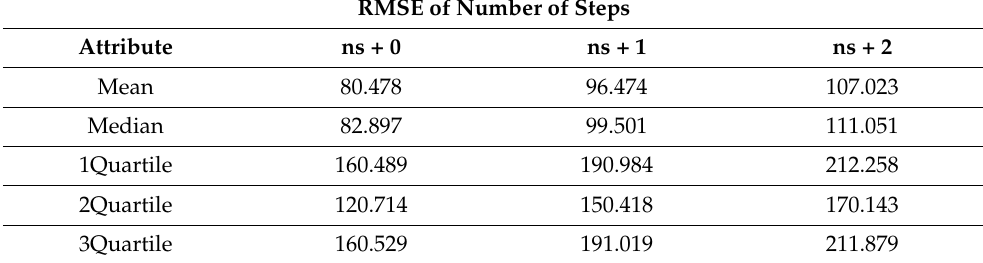
Table 5. RMSE of number of